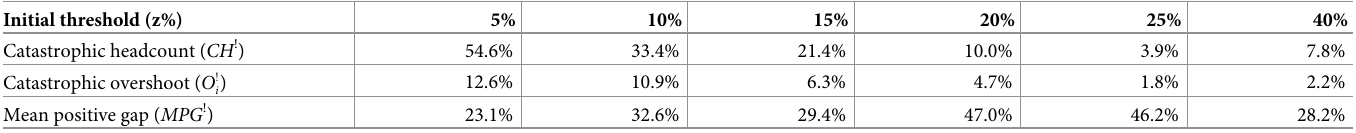
Table 3. Incidence and intensity of catastrophic out-of-pocket medical expenditures among CVDs patients accessing healthcare in public and private hospitals in Ibadan.